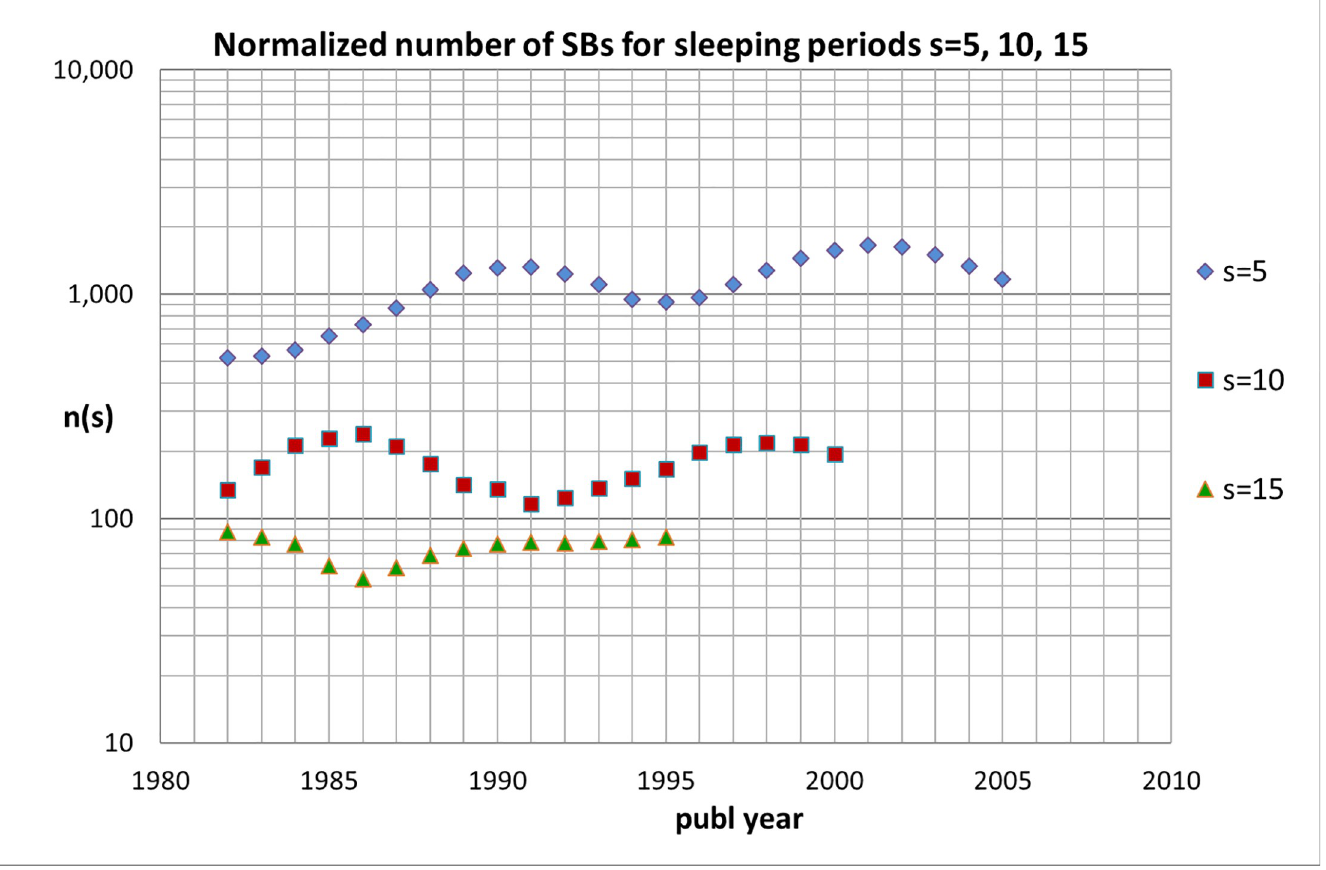
Fig 3. Trend of the normalized numbers n(s) of SBs in the medical research fields; numbers are the totals of successive five-years blocks, each five-years block is located in the figure by its middle year.